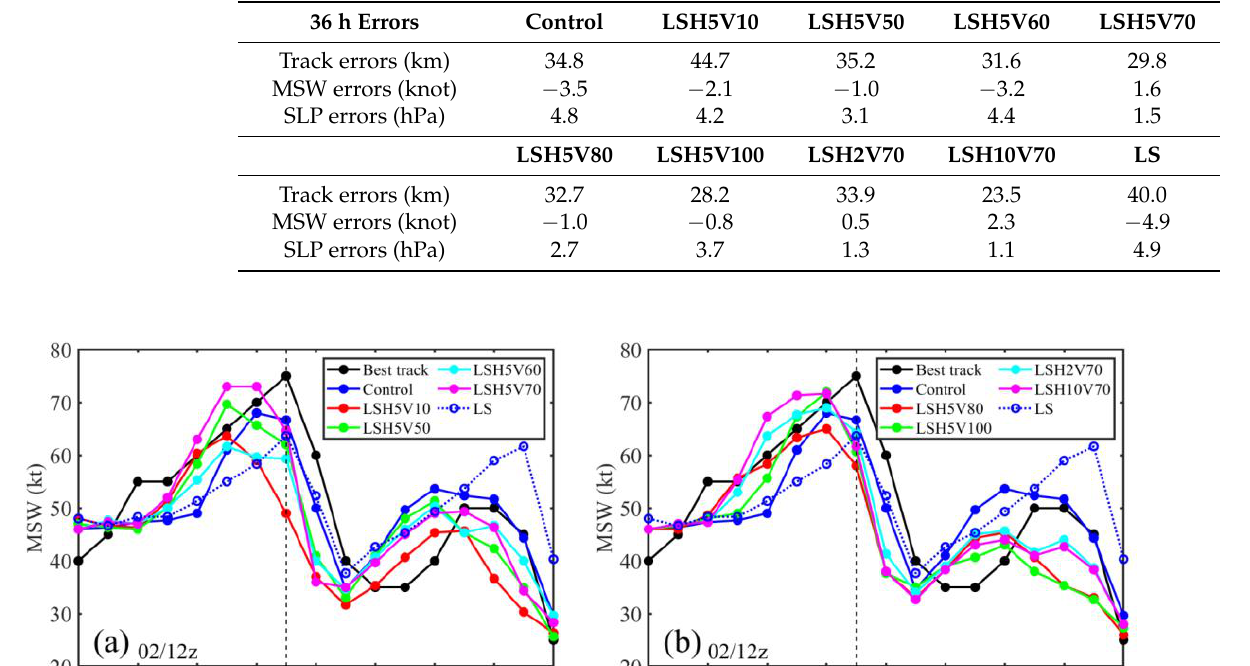
Table 3. The 36 h forecast errors from data thinning experiments with lidar wind-speed data assimi- lation at 12 UTC 2 August 2016.